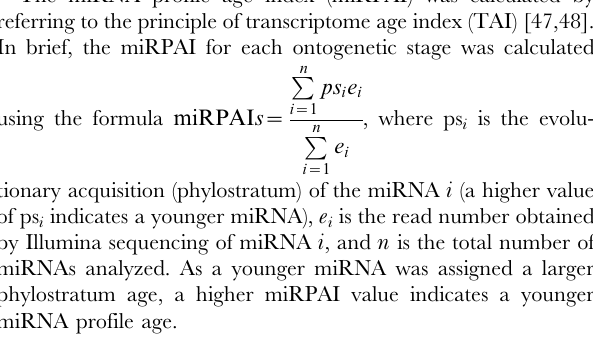
Table S3 Reads annotation results for different RNA categories. Table S4 Details of the 81 conserved precursors